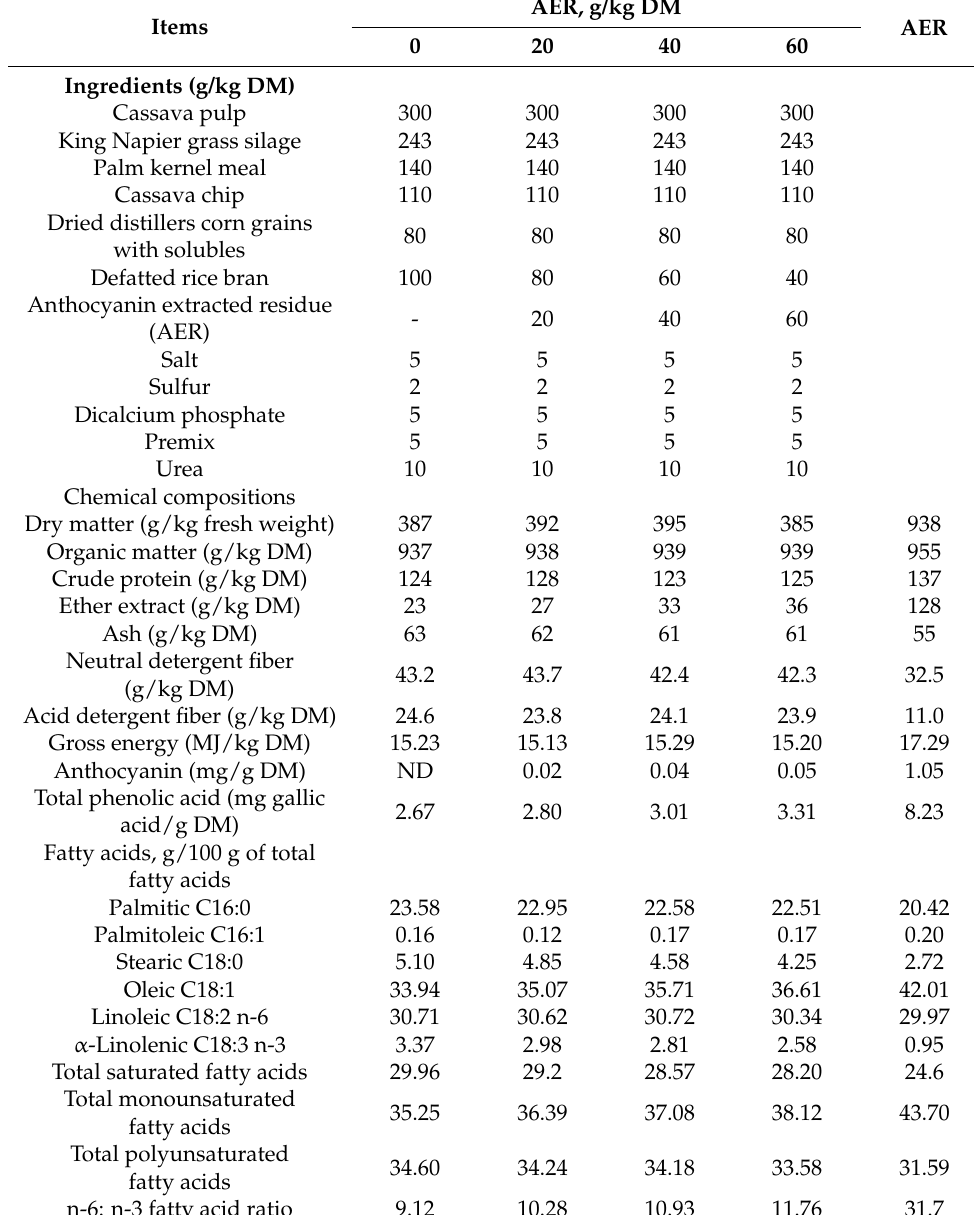
Table 1. Ingredients, chemical compositions and fatty acid profile of total mixed ration (TMR)